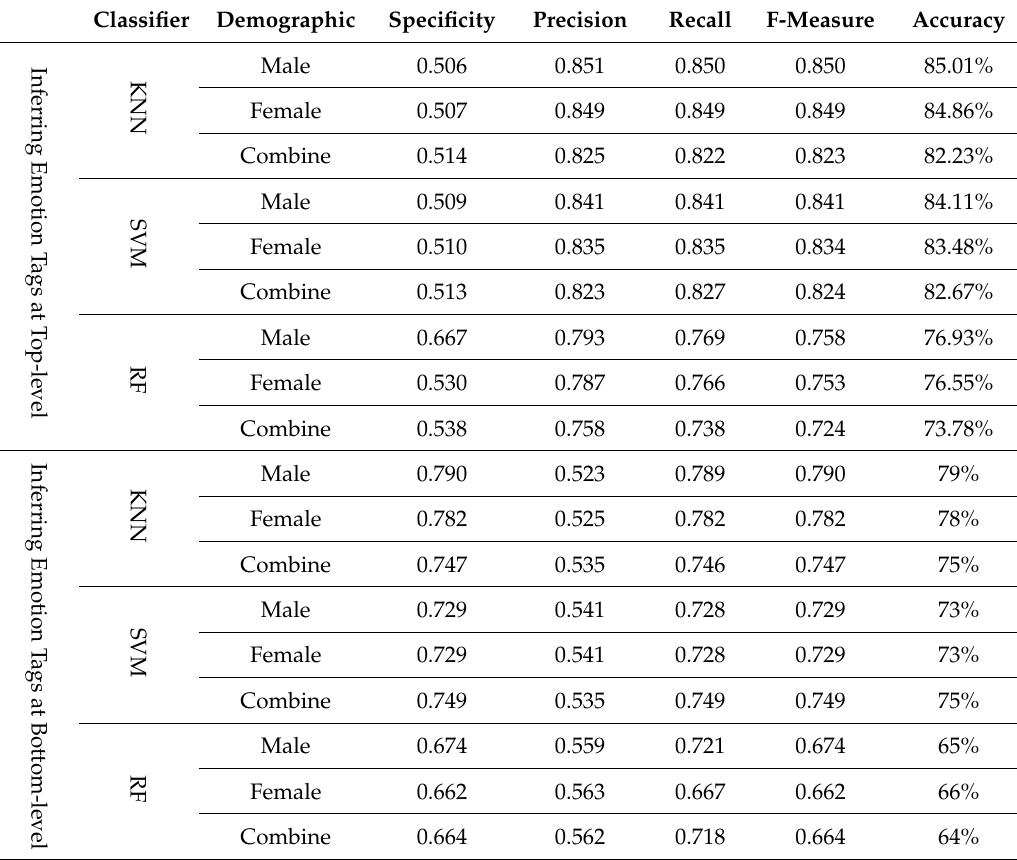
Table 2. Result analysis of inferring emotion tag performance for three di ff erent classifiers at top and bottom–level using